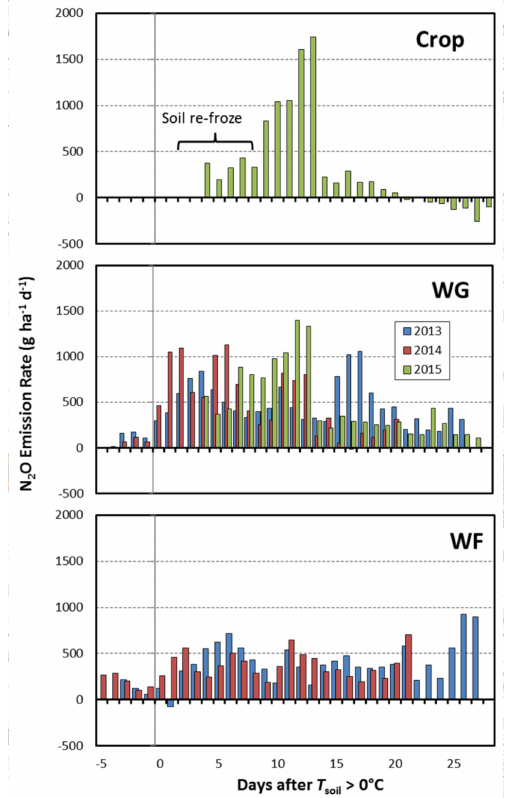
Figure 4. Daily N 2 O emission rates from the three sites during the spring thaw. Emissions plotted versus days after soil temperature at 5 cm depth ( T soil ) first exceeded 0 ◦